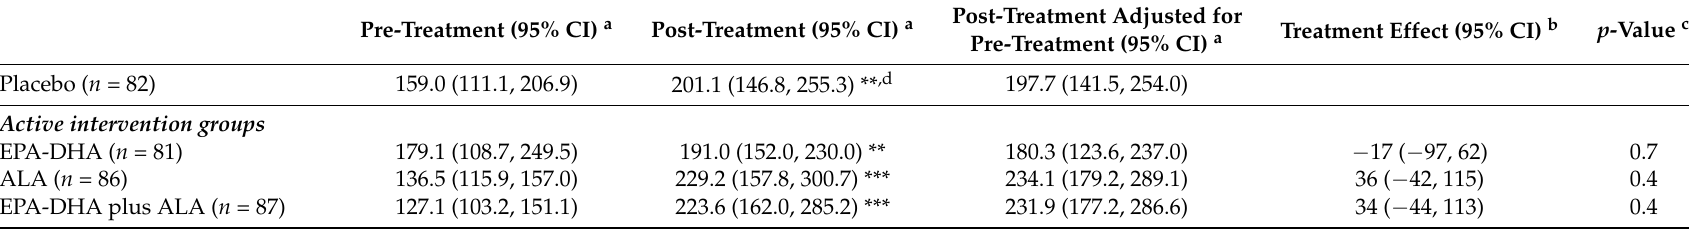
Table 2. Effect of 41 months intervention of omega-3 fatty acids on change in FGF23 levels in 336 patients of the Alpha Omega Trial according to study group with